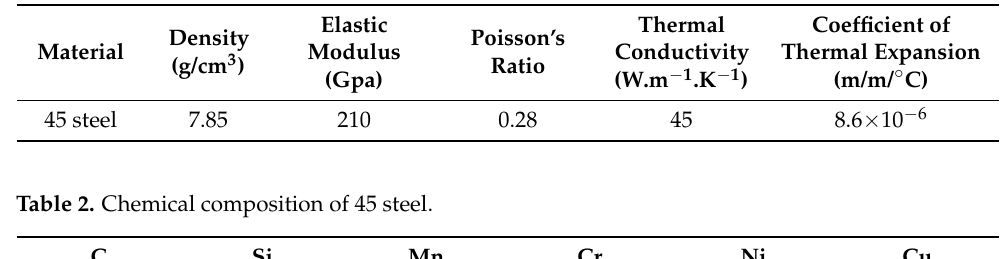
Table 1. Properties of 45 steel. Table 2. Chemical composition of 45 steel.